Question: Looking at the figure, what chart type is it?
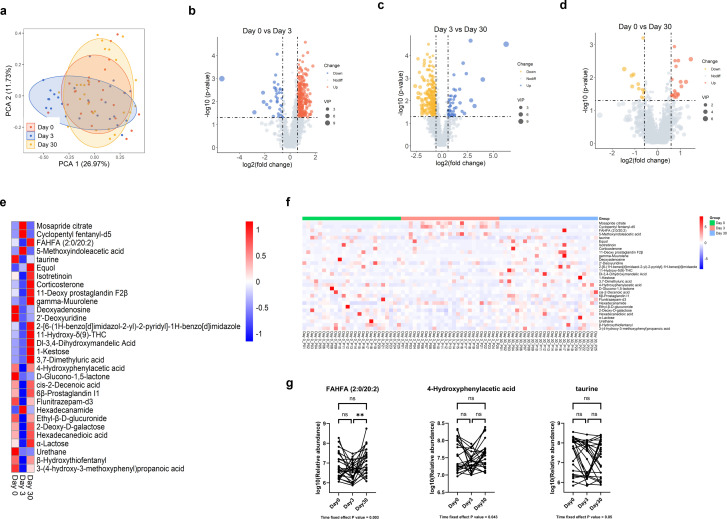
Answer: heatmap